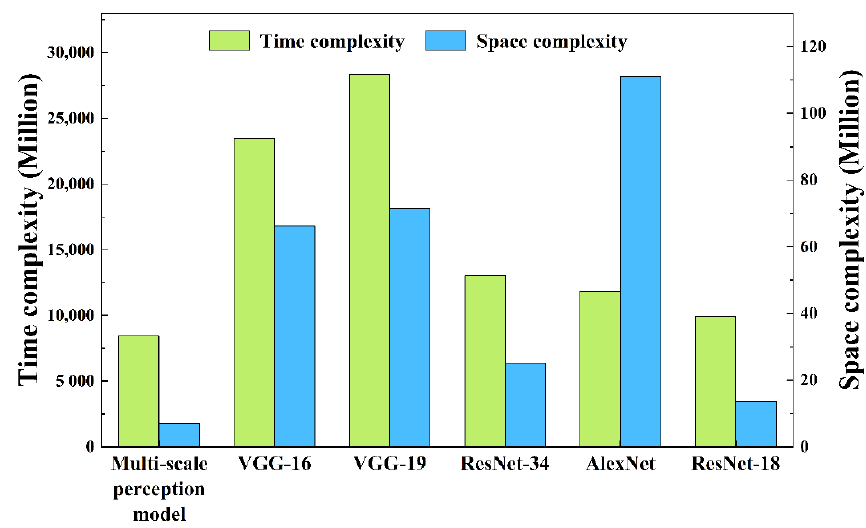
Figure 12. Comparison of the complexity of different models.